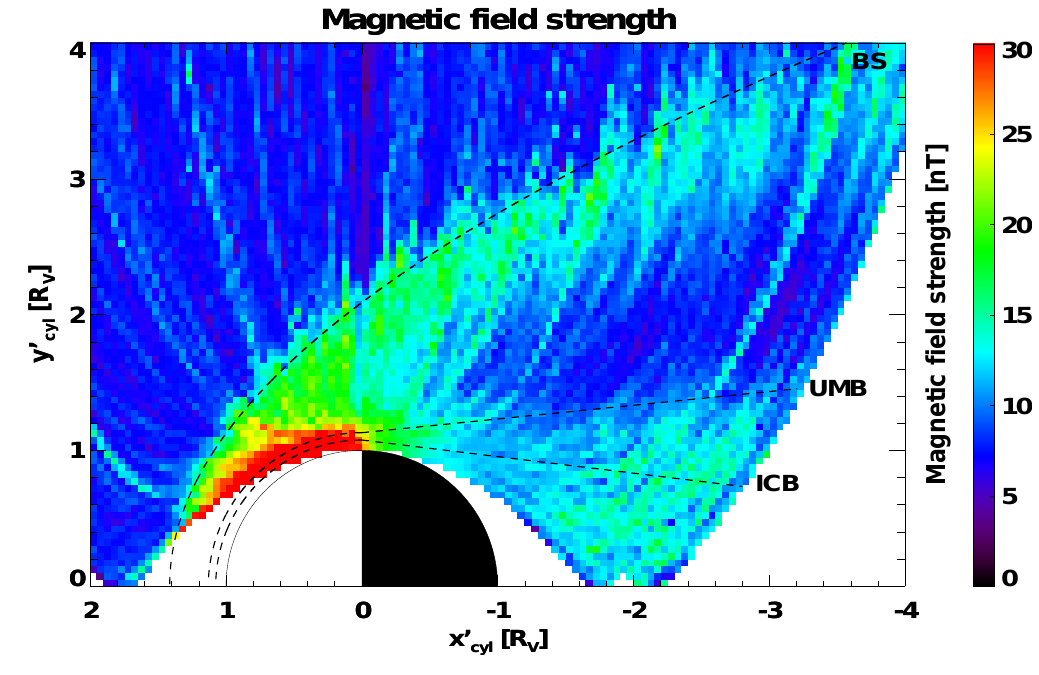
Fig. 1. Spatial distribution of the magnetic field strength in the plasma environment surrounding Venus. The measurements are averaged around the axis of the apparent solar wind direction (x 0 ). Downstream of the bow shock (BS) the magnetic field strength is enhanced cyl relative to the solar wind region upstream of the bow shock and piles up towards the terminator in the low-altitude dayside magnetosheath forming the magnetic barrier. Draping of the magnetic field around the planet leads to the formation of the magnetotail which is characterised by a slightly enhanced magnetic field strength in the planet’s wake,